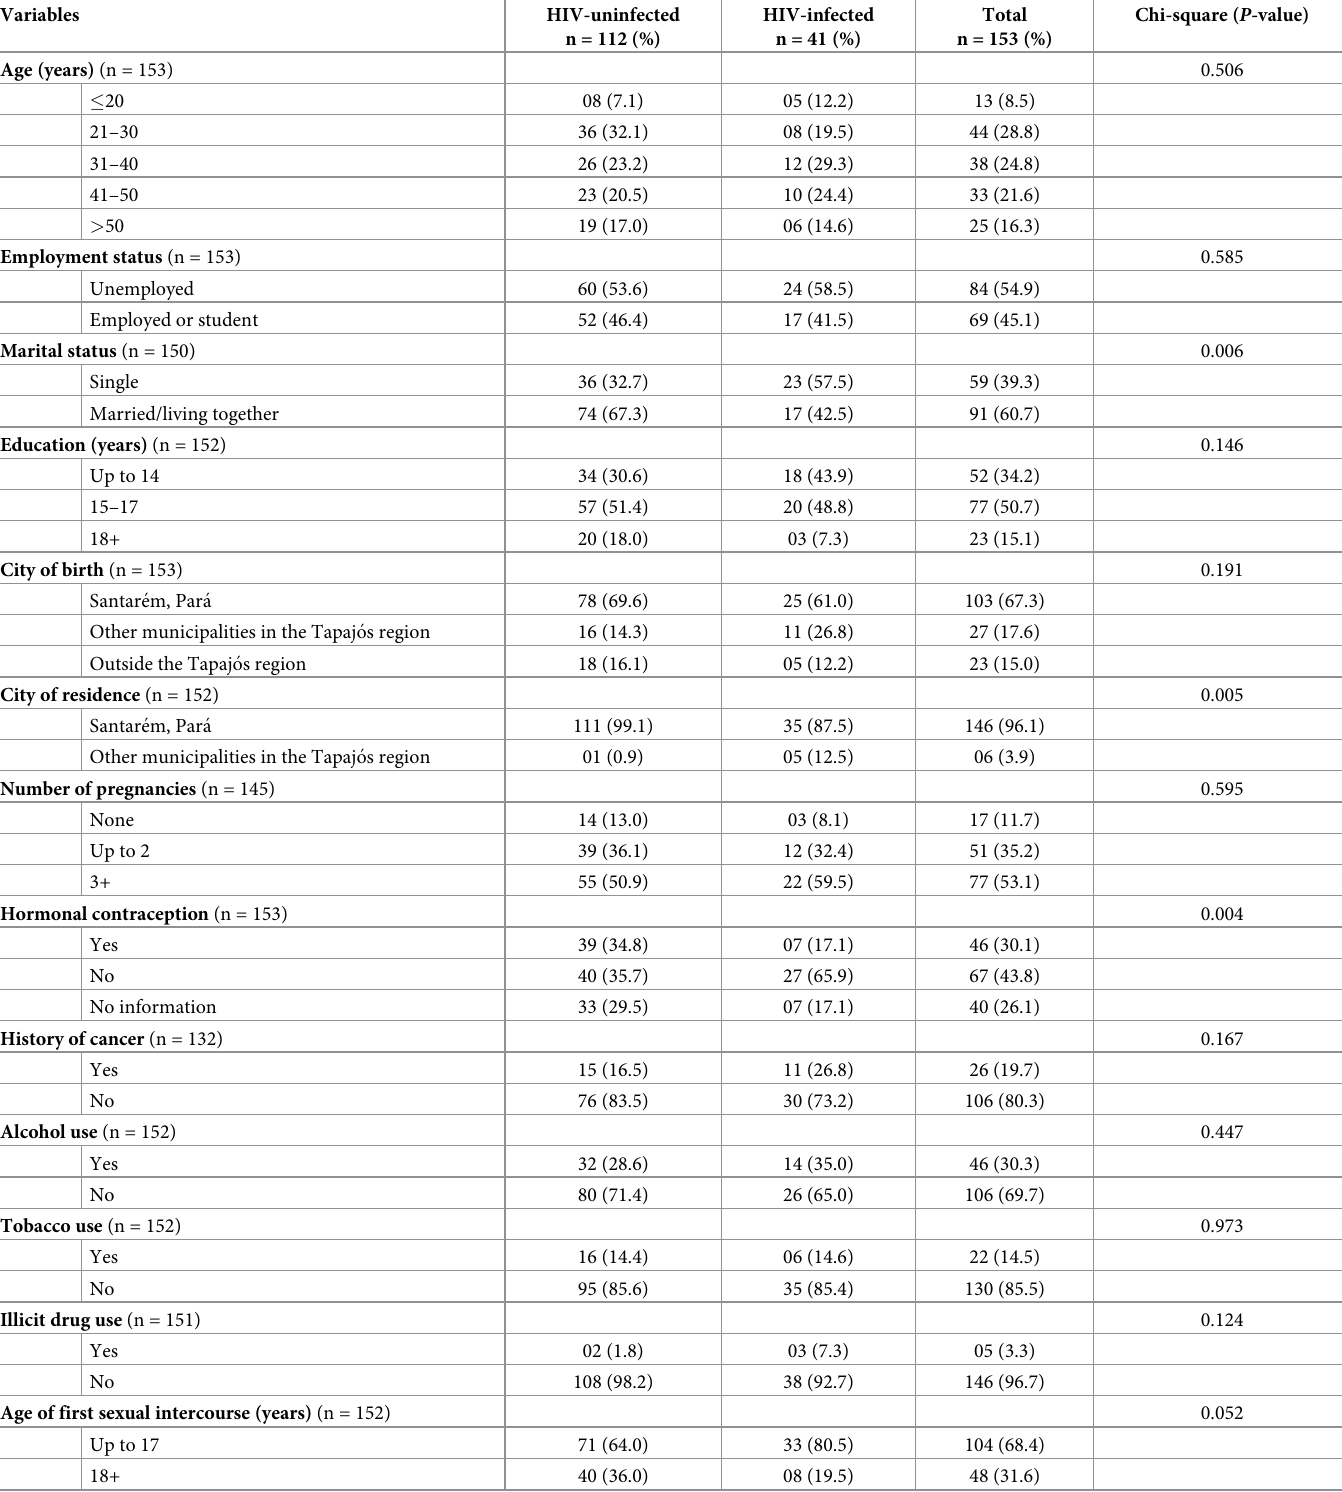
Table 1. Epidemiological variables of HIV-uninfected and HIV-infected